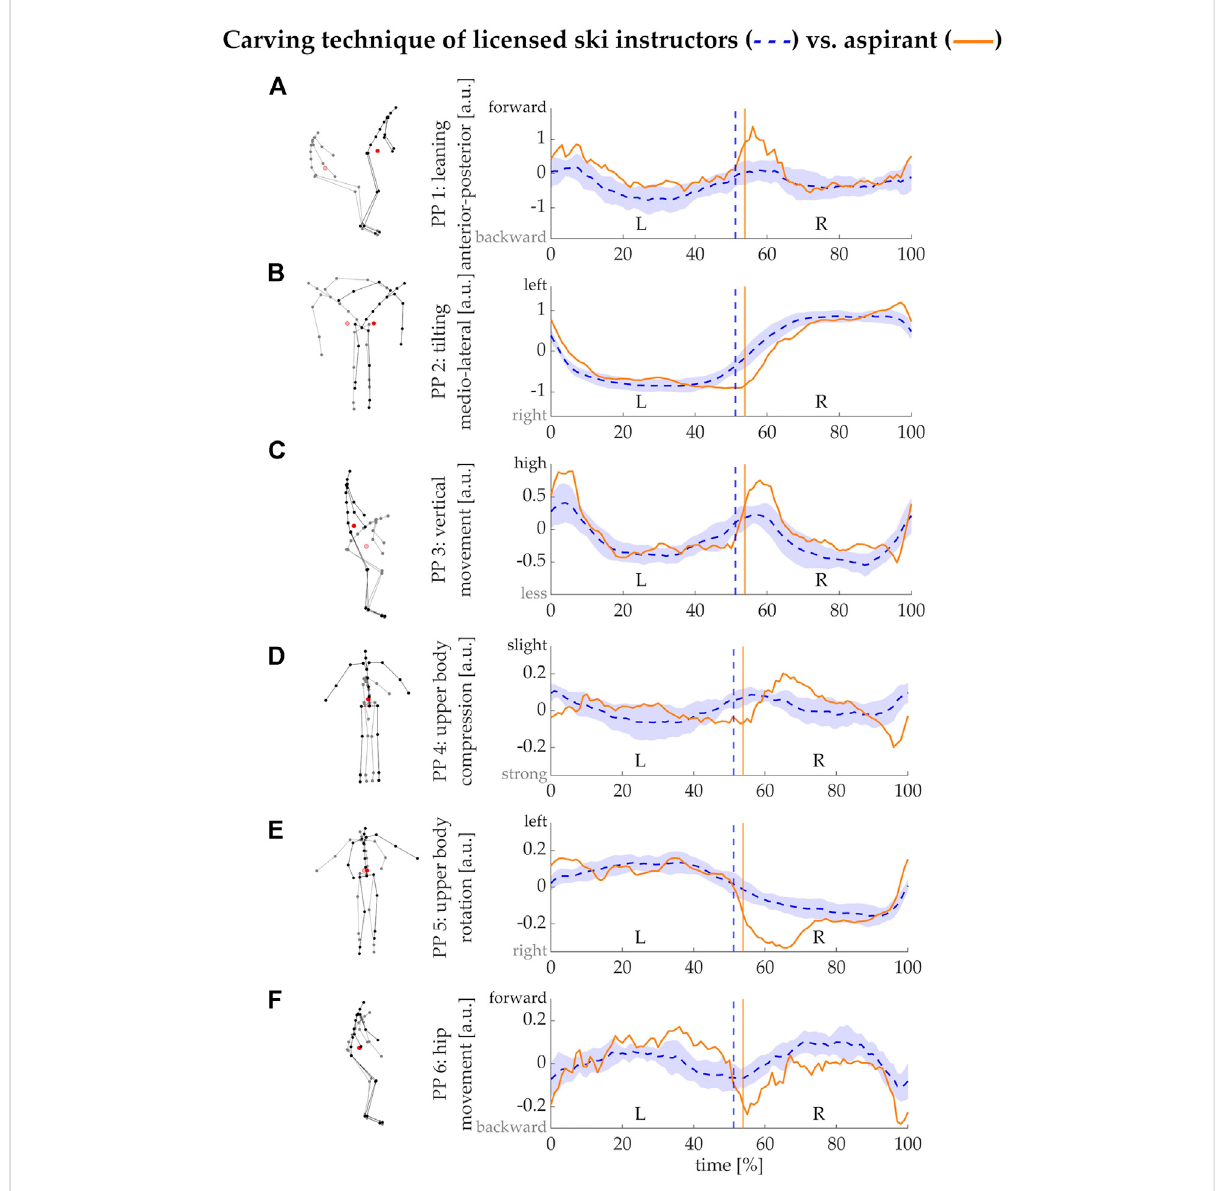
FIGURE 6 Casestudy:comparisonoftheindividualtechniqueofaspeci fi cskierwithreferencedatafromtheskiinstructors.PM1-6 (A – F) ,visualizedbythe stick fi gures and displayed by the PP(t) series are adopted from Figure 4 for all carving turns of the skiers with active ski instructor license (blue lines and shaded areas for mean and standard deviation). The recorded carving turns of the aspirant are projected onto the same PM-coordinate system (orange